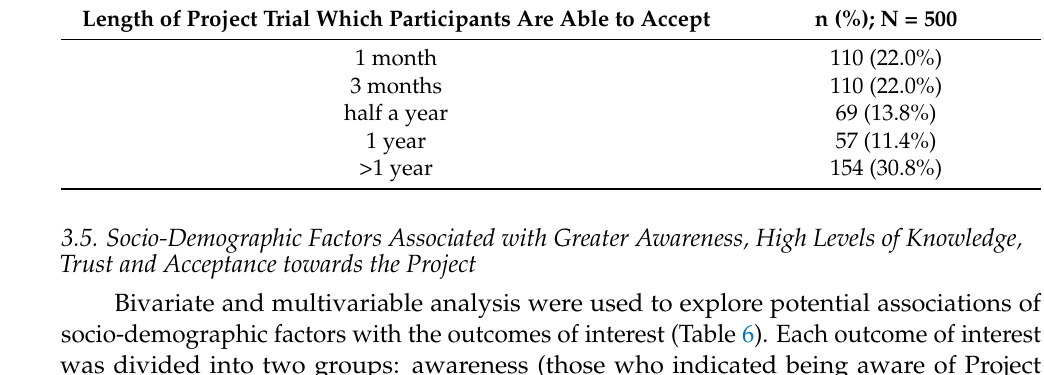
Table 5. Length of project trial that is acceptable in participants’